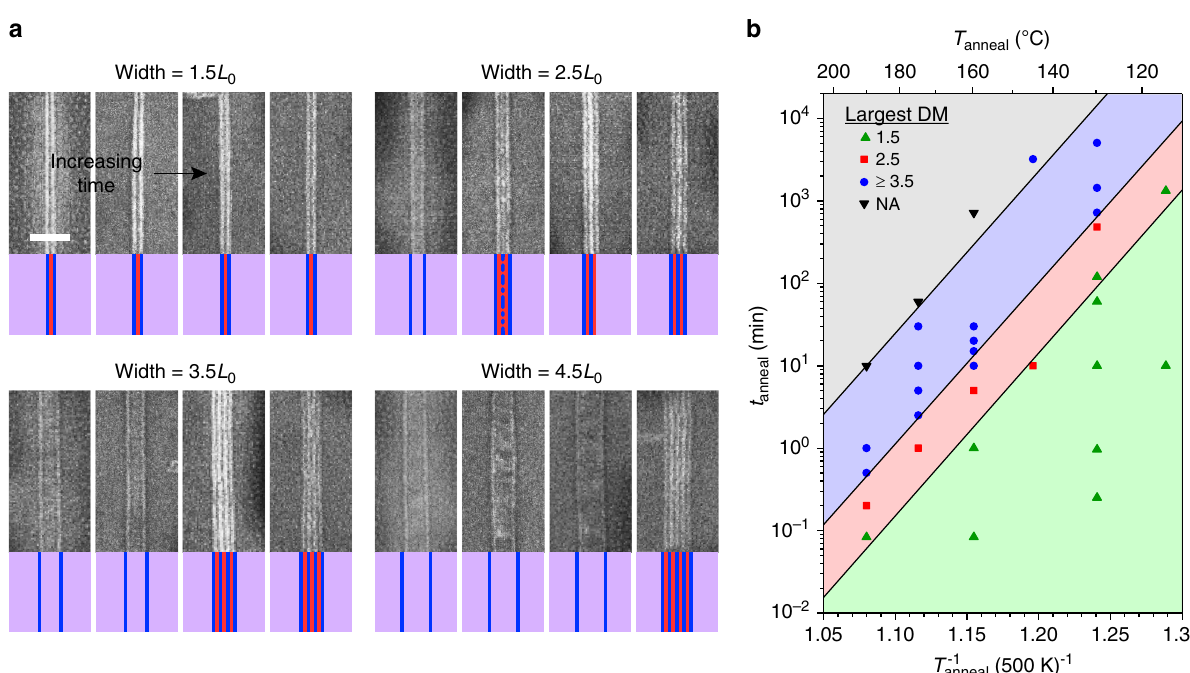
Fig. 3 Effect of anneal time, anneal temperature, and stripe width. a SEM images and schematic diagrams corresponding to PPC-b-PS-b-PPC ( L 0 of 12.8 nm) morphology after assembly at 130 °C for 1, 10, 1440, and 5040 min (left to right) on stripes with width of ~1.5, 2.5, 3.5, and 4.5 L 0 . Vertical PS and PPC lamellae are blue and red, respectively, and horizontal lamellae are purple. Scale bar is 100 nm. b Plot of the largest density multiplication factor (DM) achieved as a function of anneal time ( t anneal ) and anneal temperature ( T anneal ). Each data point represents a unique assembly experiment, in which the largest density multiplication is 1.5 (green upward triangles), 2.5 (red squares), ≥ 3.5 (blue circles), or not applicable (NA) because BCP did not assemble (black downward triangles). Black lines and shading are shown only to highlight approximate